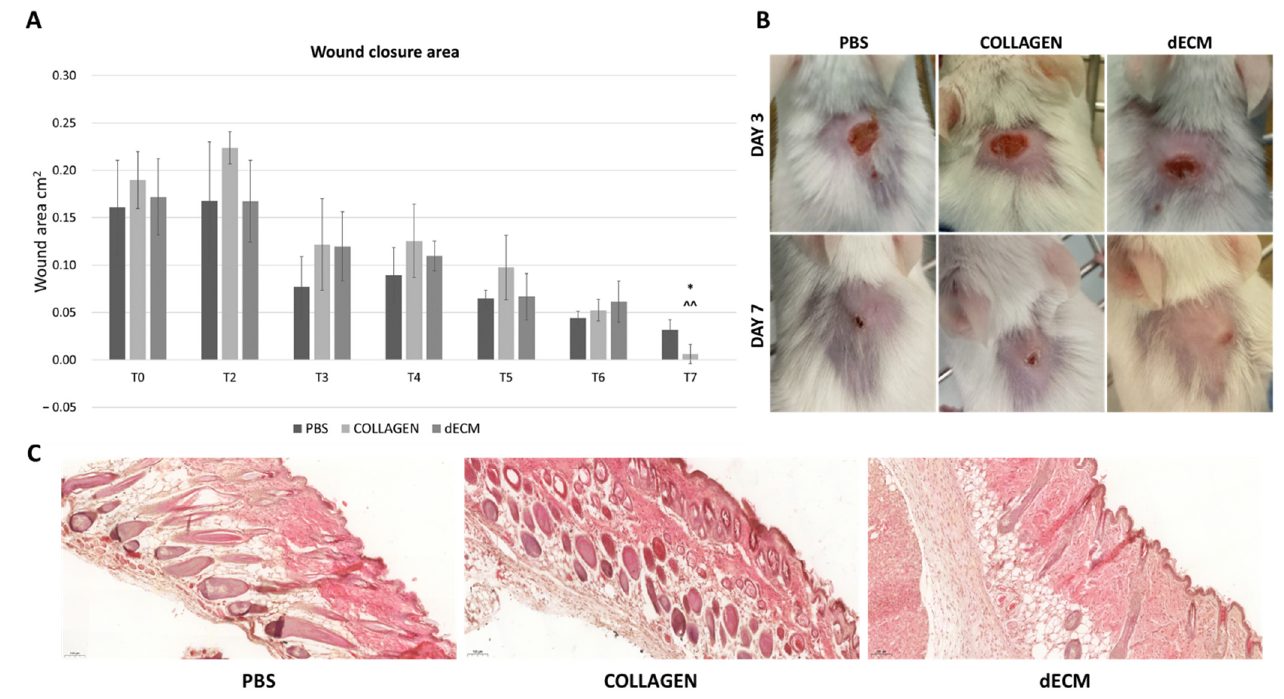
Figure 9. Wound healing model. ( A ) Wound area, expressed in mm 2 , of wound treated with PBS, collagen and 8 mg/mL dECM, from day 1 to day 7. Data are means ± S.D. of 3 samples for each condition. *: p < 0.05 collagen vs control; ^^: p < 0.01 dECM vs control. ( B ) representative images of wound area in wound healing models treated with PBS, collagen and dECM at day 3 and 7. ( C ) histological samples of transverse wound areas. The images display the tissue architecture of wounds treated with PBS, collagen and 8 mg/mL dECM at day 7. Magnification 10×. On day 7, specimens from each condition were collected for histological analysis.